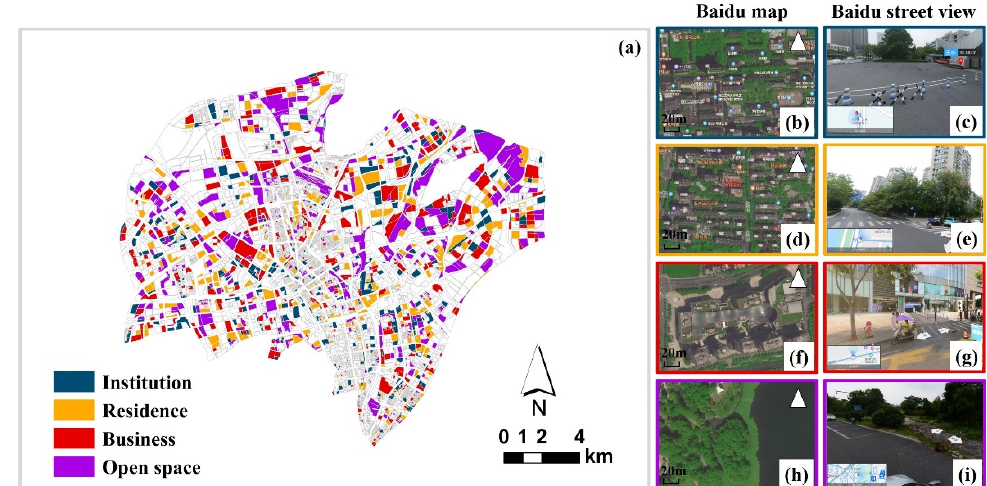
Figure 5. Spatial distribution and illustration of training and testing parcels for the four urban land use types. ( a ) represents the spatial distribution of training and testing parcels; ( b , d , f , h ) represents the Baidu map image for institution, residence, business, and open space, respectively; and ( c , e , g , i ) represent the Baidu street view for the institution, residence, business, and open space, respectively. The Chinese labels for ( b , d , f , h ) represent the name of POIs.